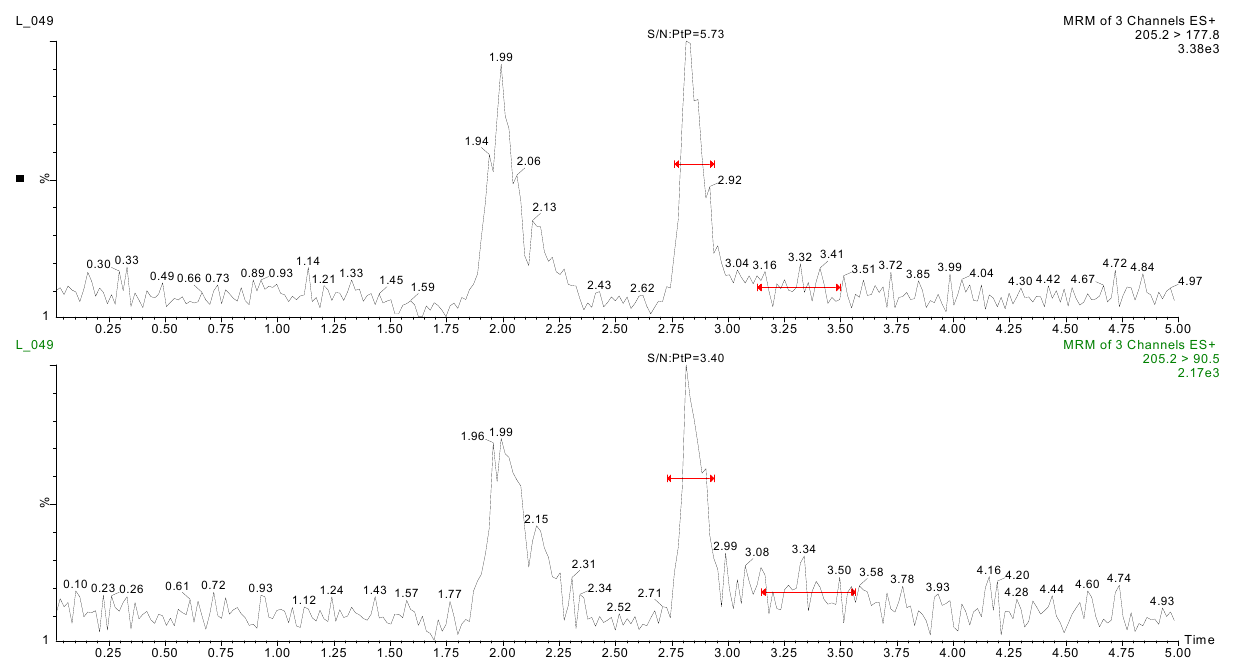
Figure A3. Chromatogram of the liver sample treated at detection limit (LOD) level.